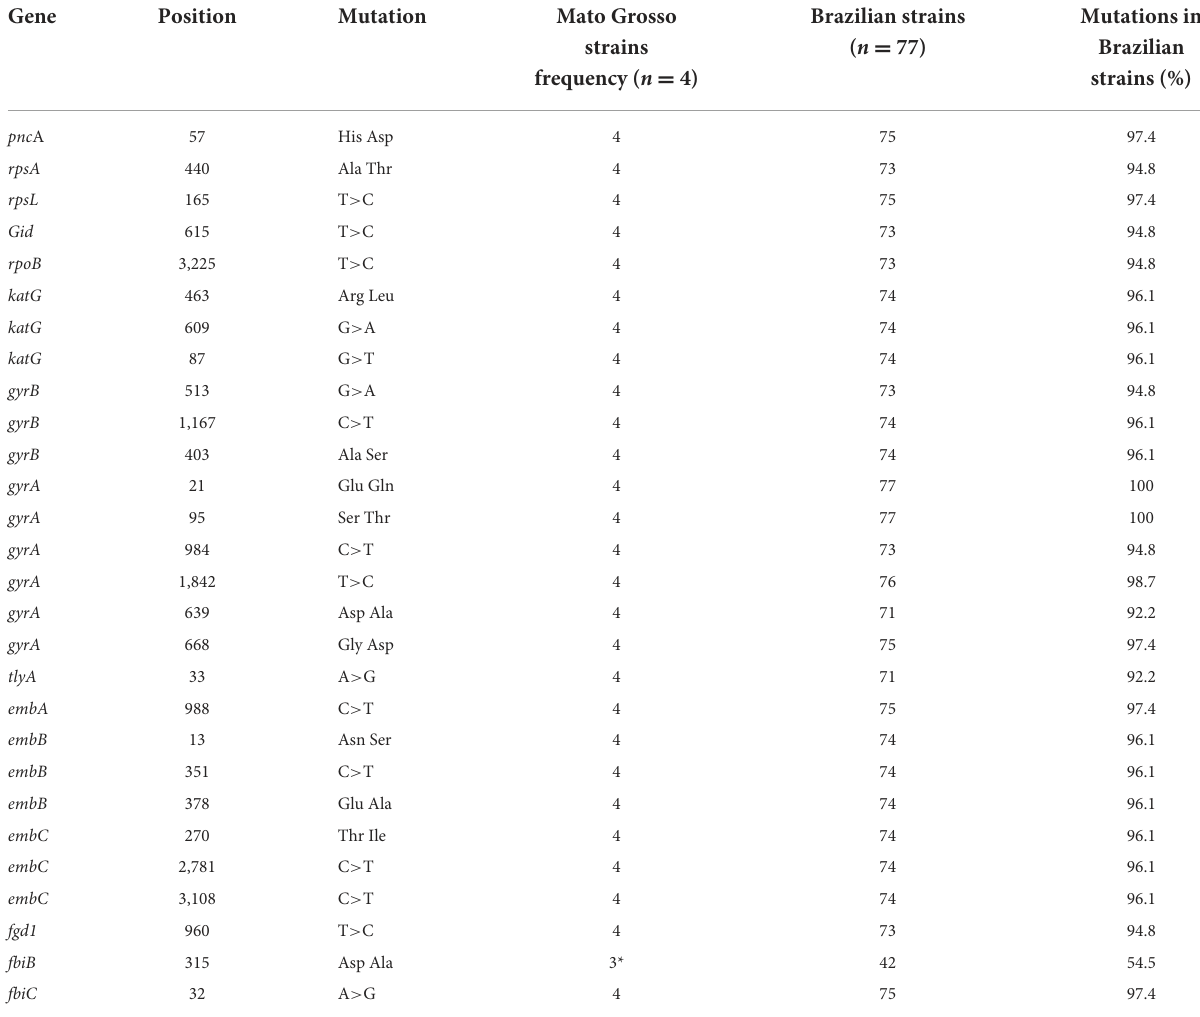
TABLE 3 Mutations present in Mycobacterium tuberculosis variant bovis strains isolated from caseous lesions obtained from bovine carcasses in the state of Mato Grosso, Brazil, with other Brazilian strains. Gene Position Mutation Mato Grosso